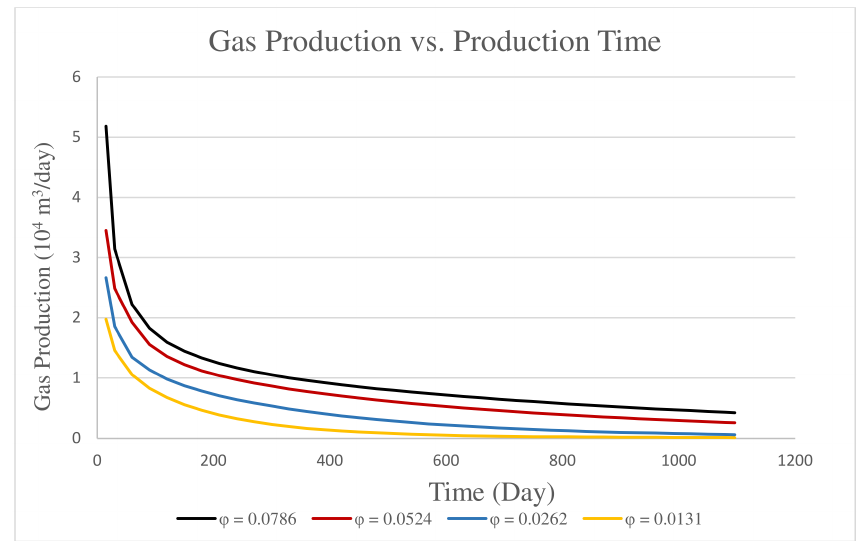
Figure 7. Simulated gas production at different